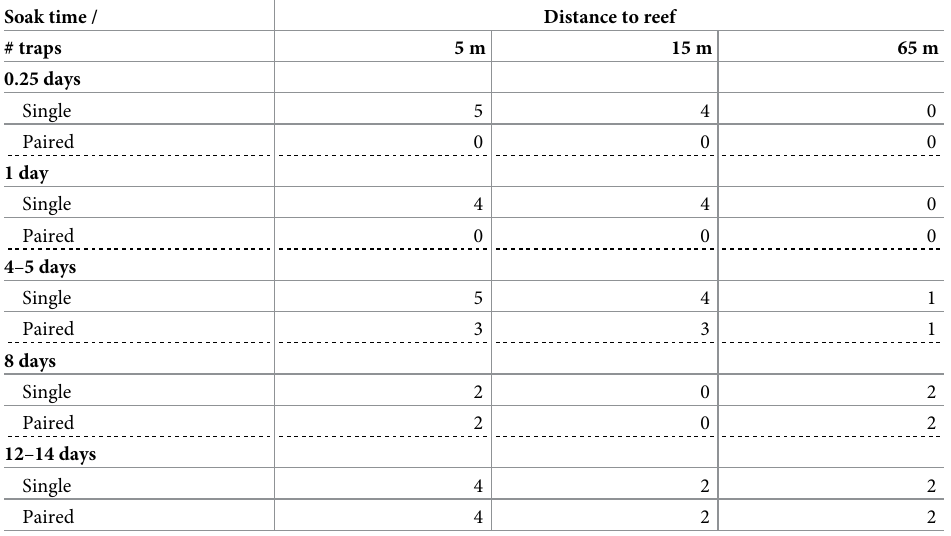
Table 2. Replicates by deployment factor tested. Soak time / Distance to reef # traps 5 m 15 m 65 m 0.25 days Single 5 4 0 Paired 0 0 0 Single 4 4 0 Paired 0 0 0 4 – 5 days Single 5 4 1 Paired 3 3 1 8 days Single 2 0 2 Paired 2 0 2 12 – 14 days Single 4 2 2 Paired 4 2 2 Number of Gittings trap replicates by deployment configuration with factors of soak time (0.25 day, 1 day, 4–5 days, 8 days, or 12–14 days), number of traps deployed (single or paired), and distance to artificial reef (5 m, 15 m, or 65